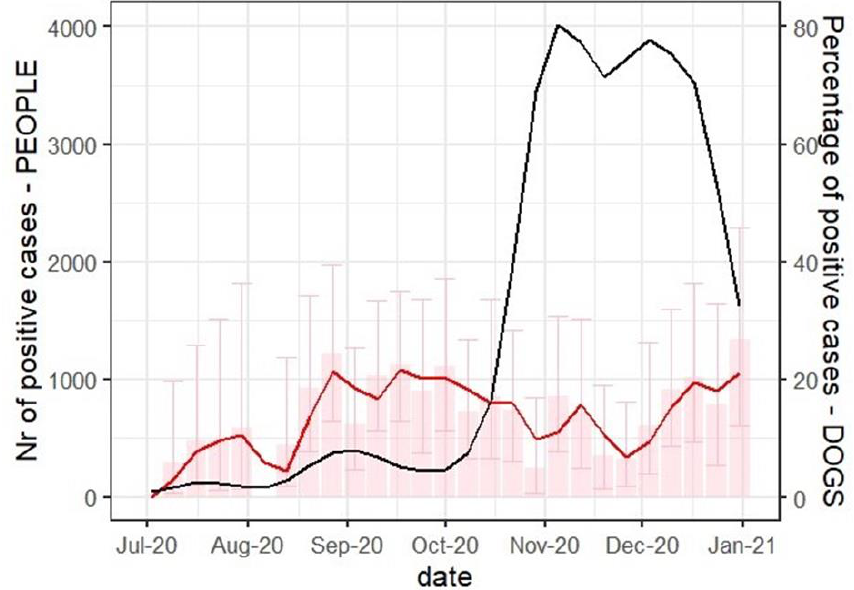
Figure 1. The weekly number of SARS-CoV-2 seropositive dogs and new q-RT PCR human cases in Zagreb from 1 July and 31 December 2020. The number of seropositive dogs is represented as a percentage of tested samples (red) and a two-week moving average trend line (red). Error bars are representing a 95% confidence interval. The number of new human SARS-CoV-2 infections in Zareb is publicly available [13] and here is represented as a two-week moving average trend line in black.